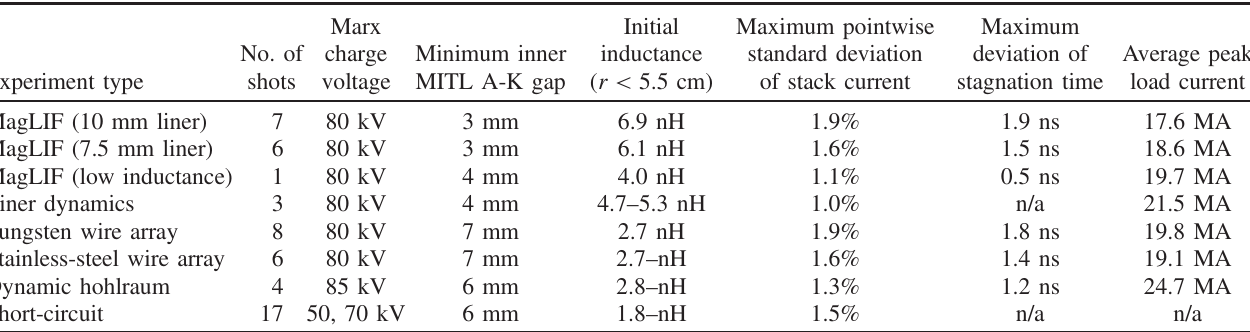
TABLE IV. Summary of Z shot configurations used to benchmark the circuit model. The physics-load implosion times range from 100 ns to 130 ns; hence the simulated implosion times agree with the measured values to within 2%.